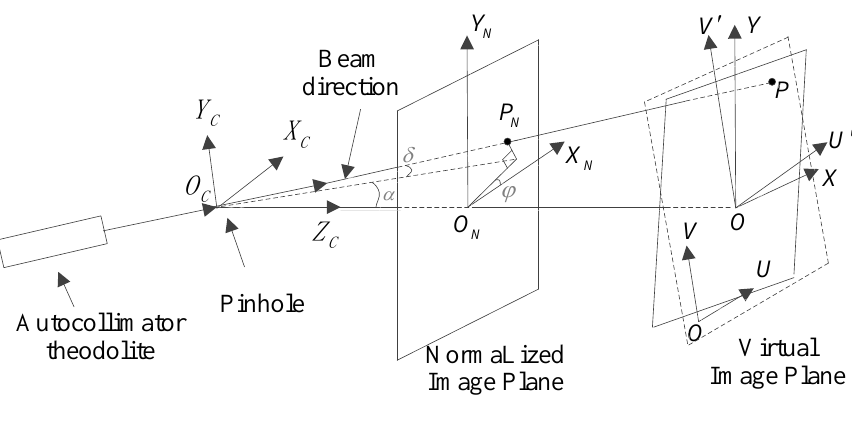
Figure 12. Coordinate systems in the case of errors.